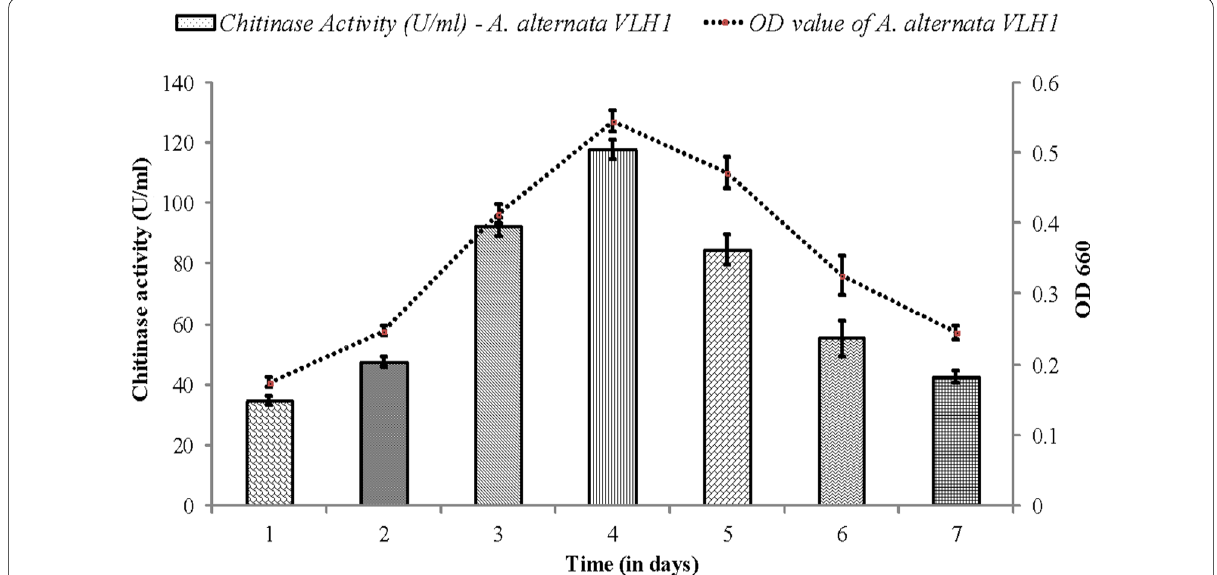
Fig. 3 Kinetics of chitinase production by protein extracts of Alternaria alternata VLH1